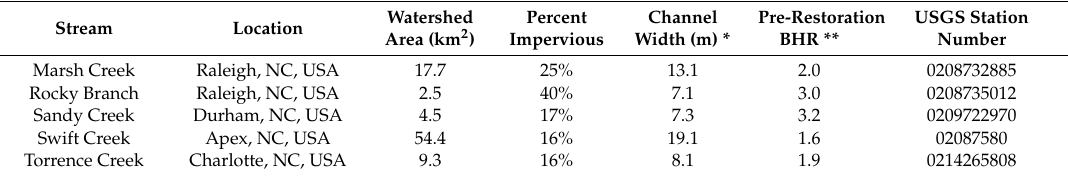
Table 1. Basic watershed and channel characteristics for five U.S. Geological Survey (USGS) stream gages analyzed for floodplain flow frequency and potential nutrient treatment.